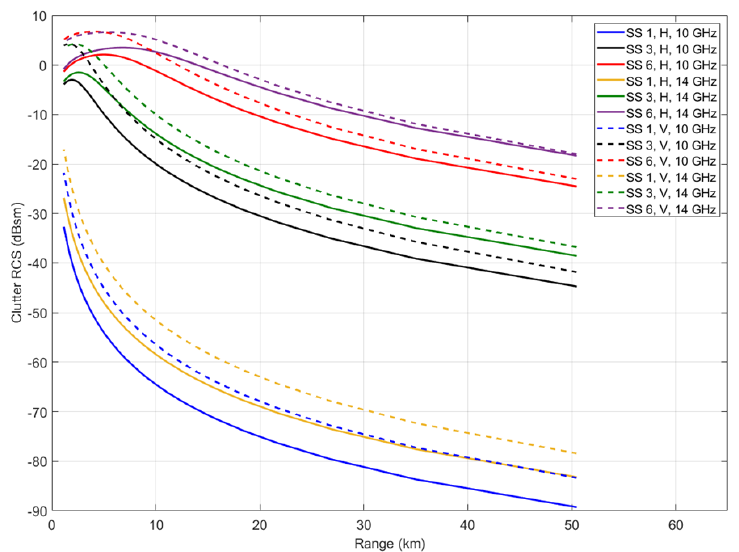
Figure 5. Typical radar cross-section of clutter versus range, frequency, polarization, and sea-state (SS).